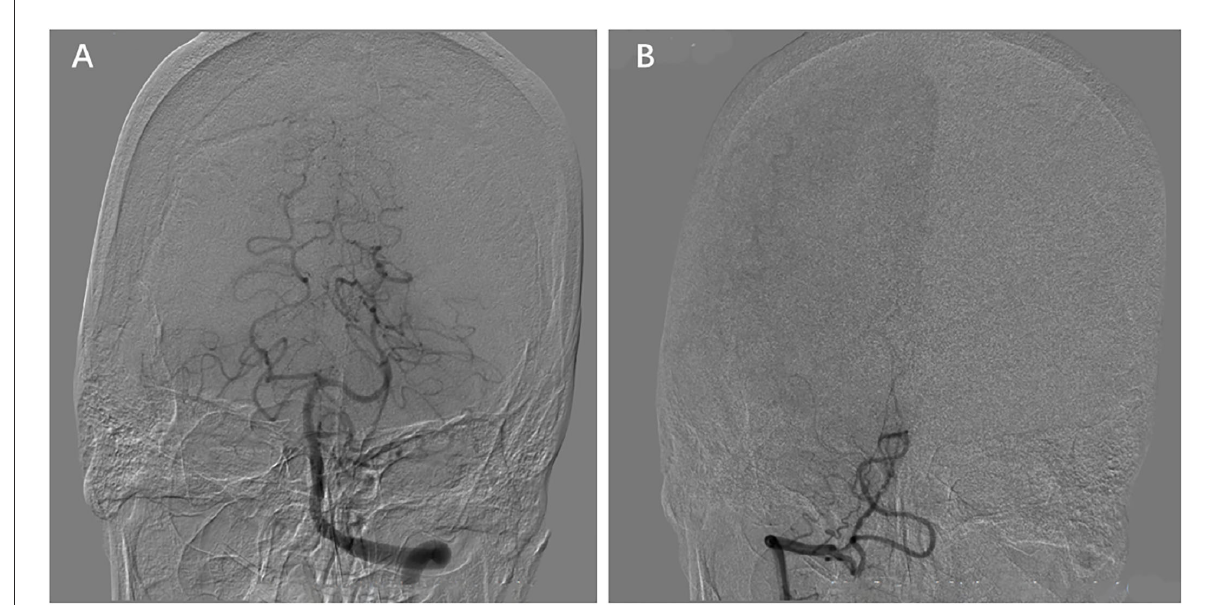
FIGURE1 Posterior inferior cerebellar artery (PICA) termination of the vertebral artery (PICA-VA). The VA on one side does not join the contralateral VA (B) , instead terminating as the posterior inferior cerebellar artery (A) .